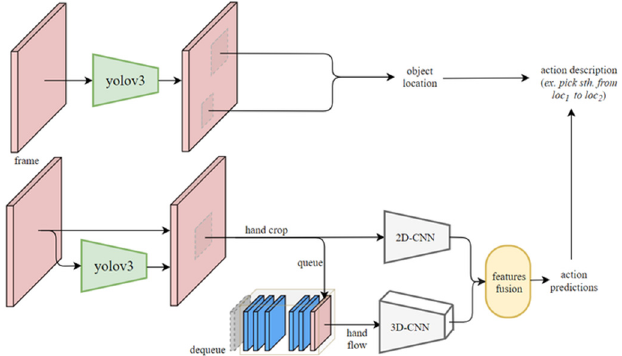
Figure 3. 3D-2D network architecture associating action detection with object detection to create an action description in the action base.